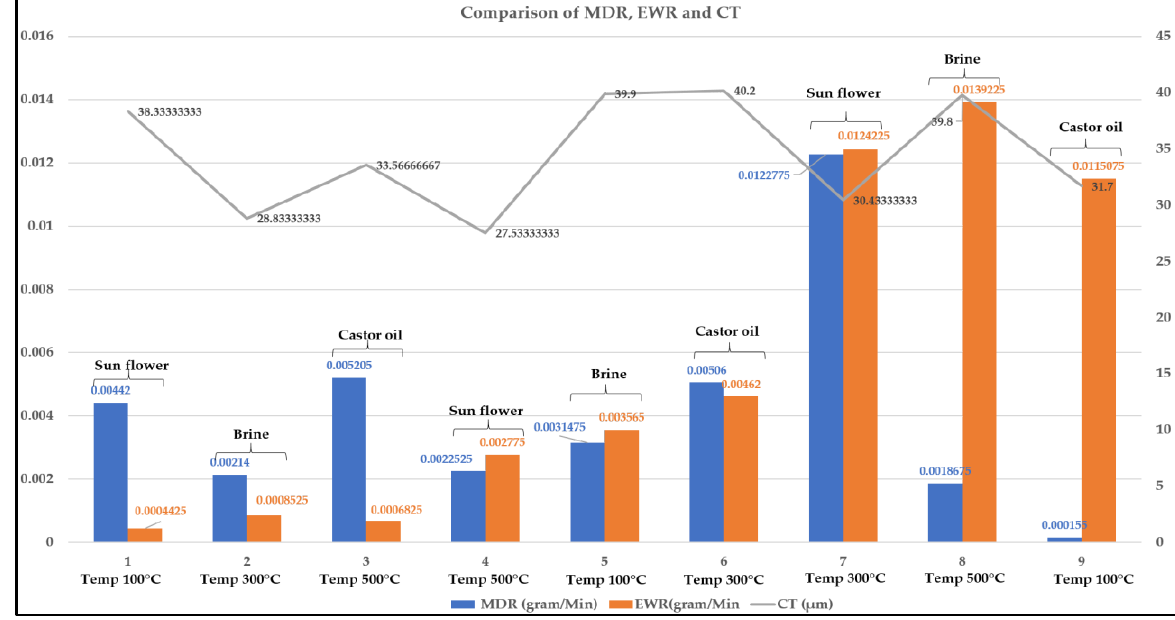
Figure 6. Comparison of MDR, EWR and CT.